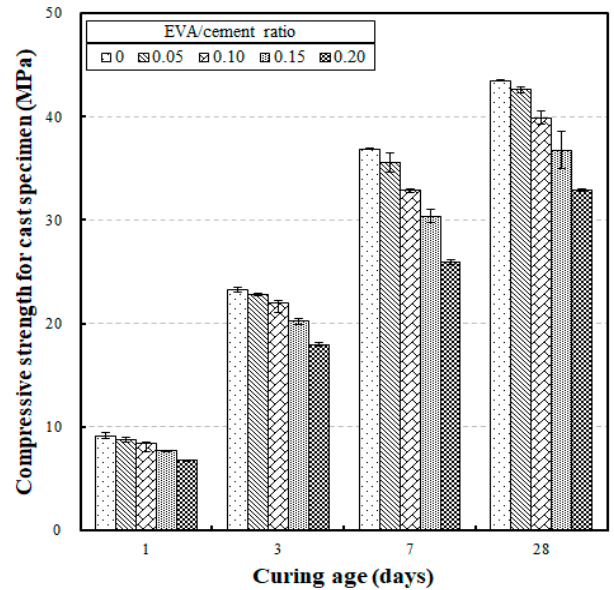
Figure 2. Compressive strength for cast specimens versus curing age according to different ethylene-vinyl acetate (EVA) / cement ratios.